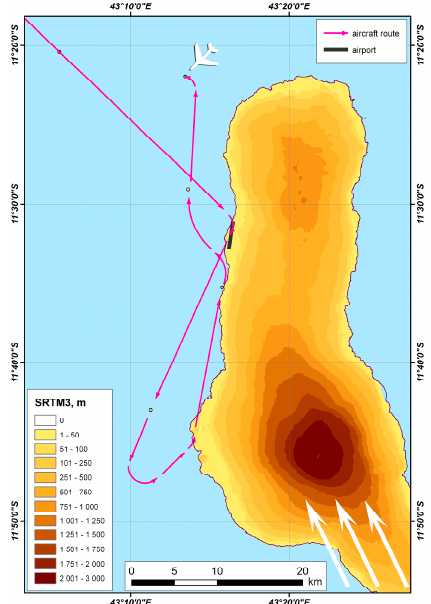
Figure 9. The Airbus A310-324 crash site, Comoros Islands, 2009. The SRTM3 with a 3 s resolution topography is drawn as a background. The white arrows show the direction of a powerful wind flow. The black line corresponds to the runway; the aircraft route is indicated by a purple line.